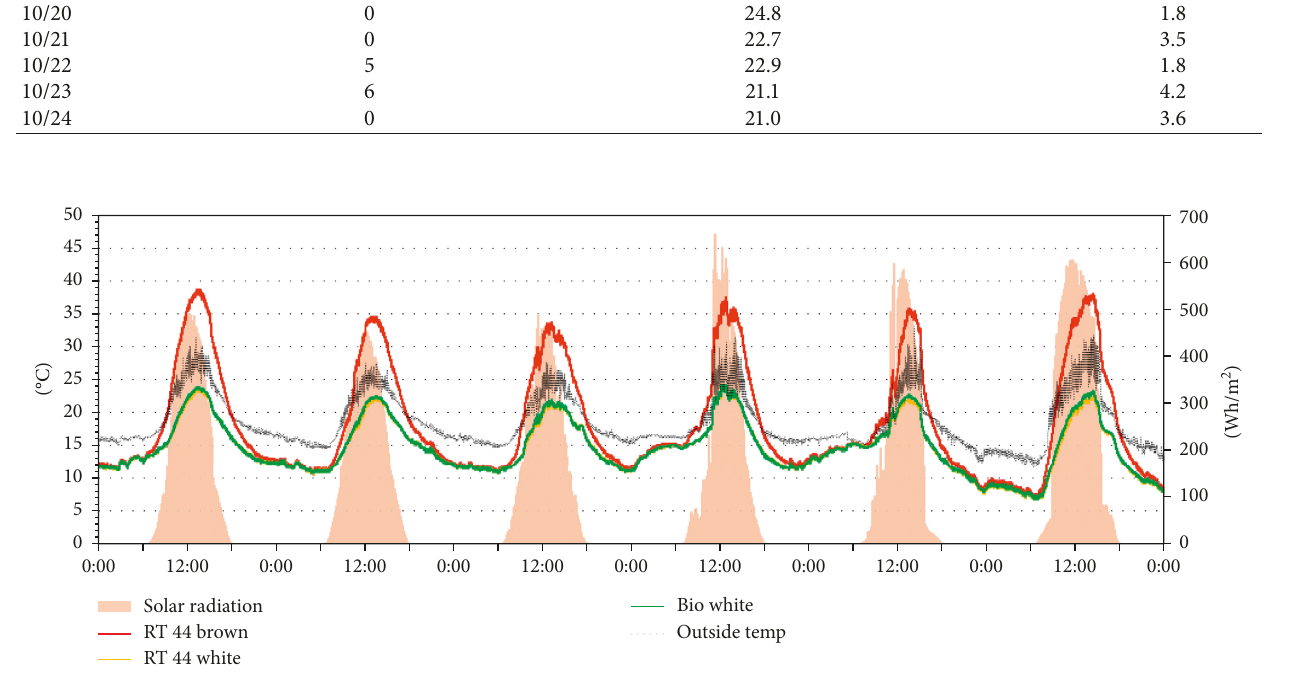
Figure 9: Ambient conditions of Test 2.